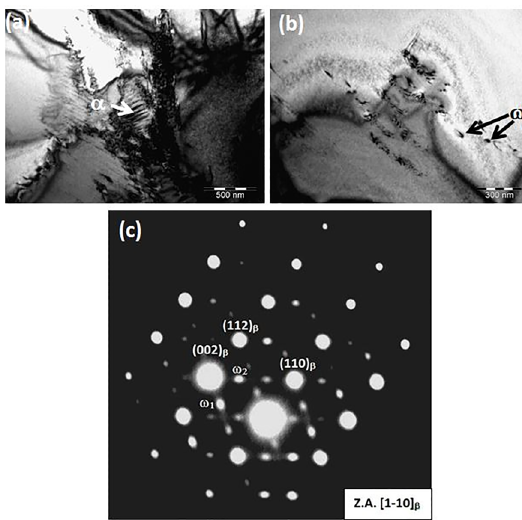
Figure 3. TEM analysis of Ti-12Mo-8Nb alloy hot swaged, annealed at 950°C/1h and water quenched: (a) bright-field α phase precipitation in a β matrix; (b) bright-field image showing ω precipitates in a matrix; (c) selected area electron diffraction pattern of region